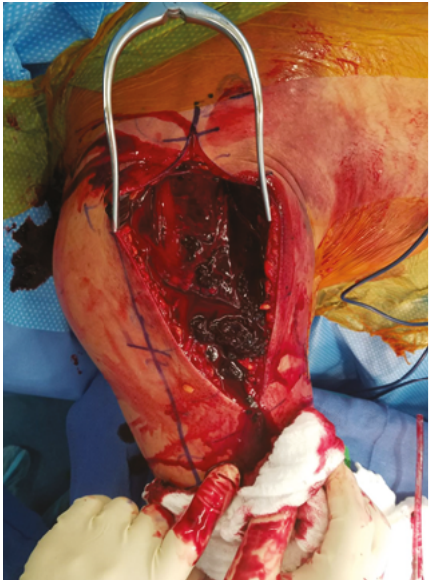
Figure 5: Muscle bulge and clot extravasation with compartment release.